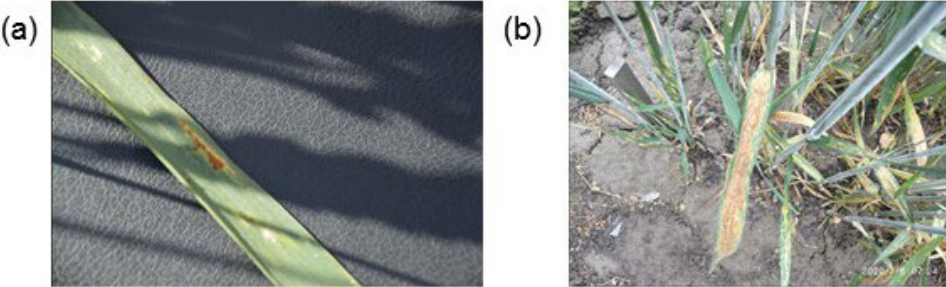
Figure 10. Examples of images marked with several disease labels at the same time, for which one of the diseases is not recognized. ( a ) Image 00c0f87c20f0fcff.jpg: labels “leaf rust” (identified) and “powdery mildew” (not identified). ( b ) Image 0dedf8d8db703948.jpg: labels “leaf rust” (not identified) and “septoria” (identified).